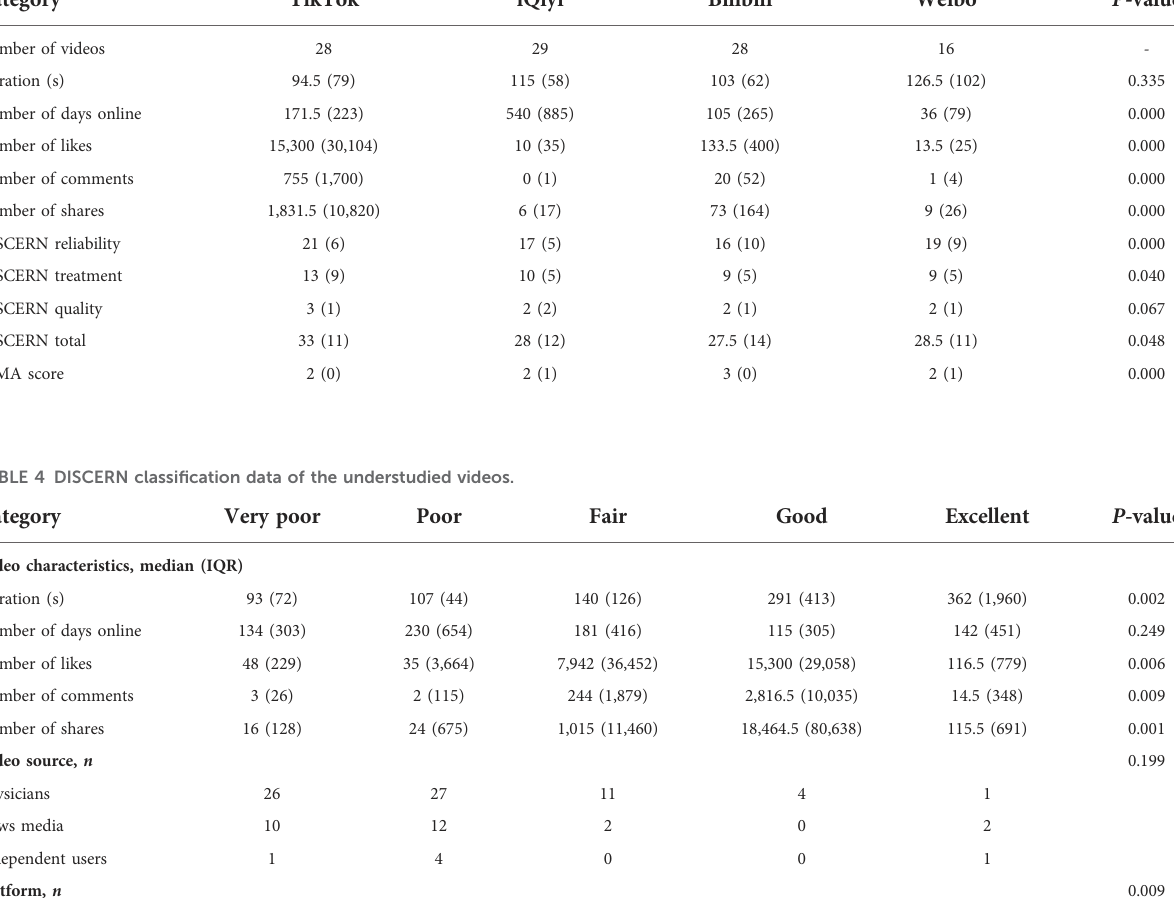
TABLE 3 General characteristics and scores of the understudied videos on the different platforms.